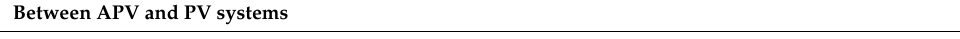
Table 9. Economic results of the comparative analysis in the scenario with equal capacity of APV and PV systems.